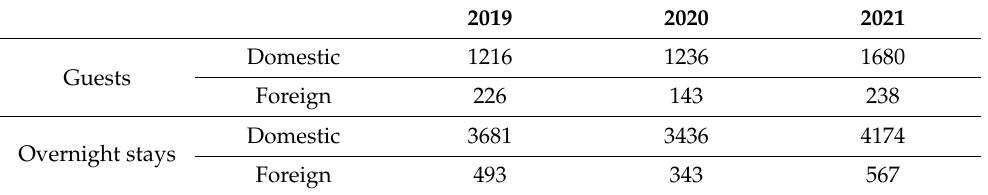
Table 1. The performance of mass accommodation facilities in Choceˇn